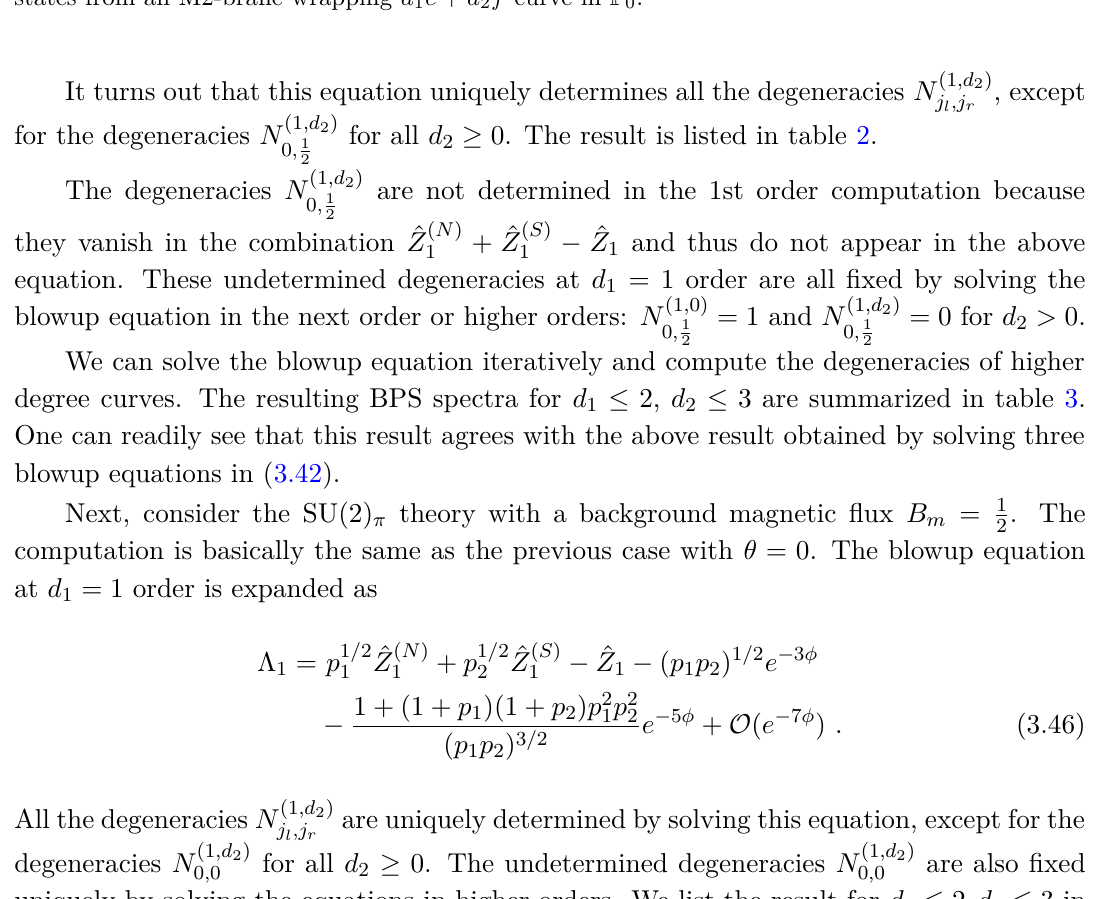
Table 3. BPS spectrum of the SU(2) 0 theory for d 1 ≤ 2 , d 2 ≤ 3 , where d = ( d 1 , d 2 ) labels the states from an M2-brane wrapping d 1 e + d 2 f curve in F 0